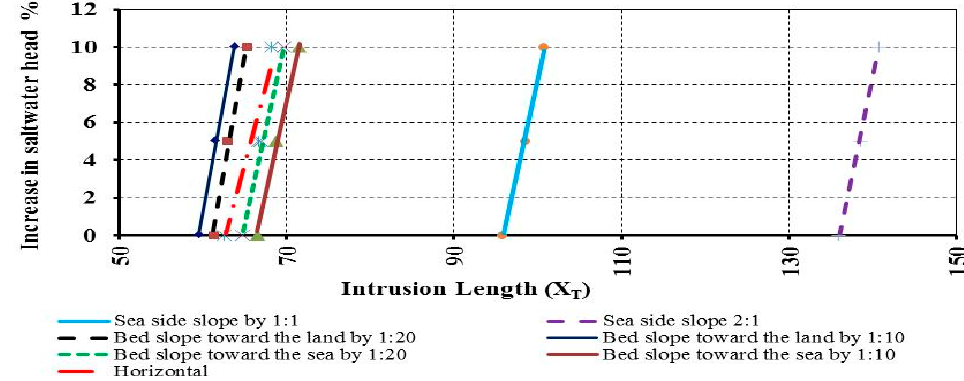
ff erent slopes.